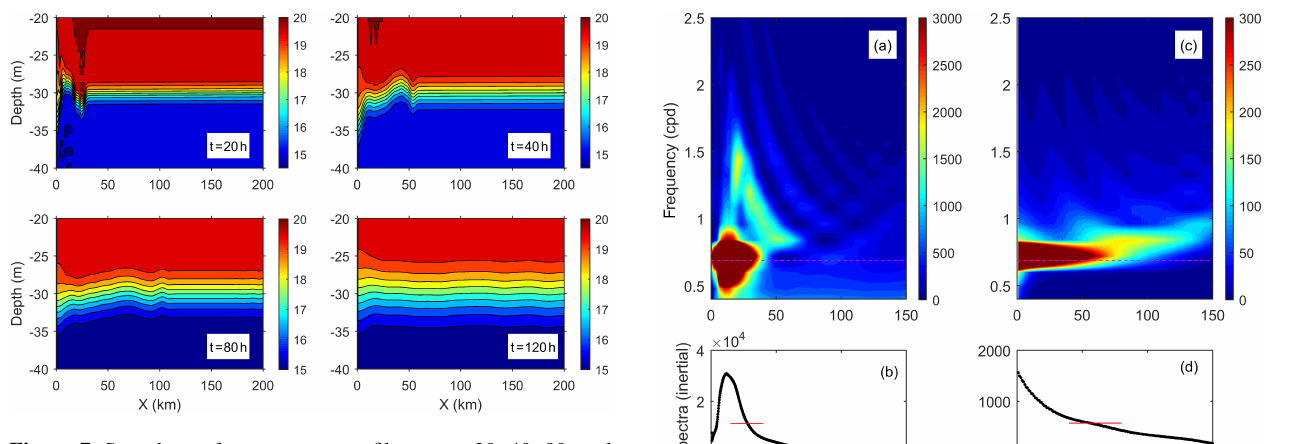
Figure 7. Snapshots of temperature profiles at t = 20, 40, 80, and 120h. The contour interval is 0.5 ◦ C.